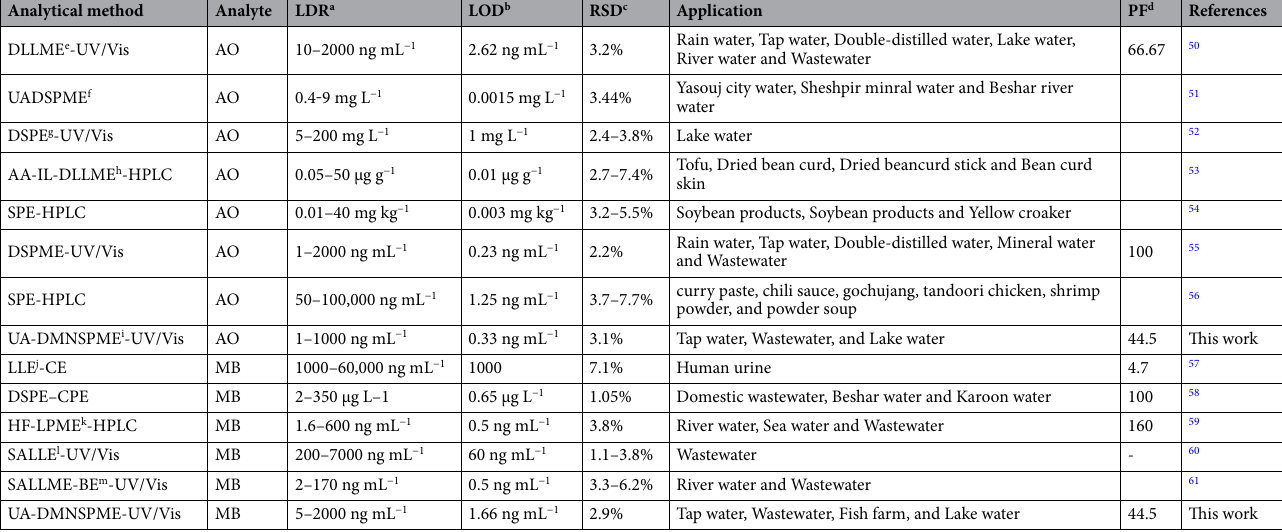
Table 7. Comparison of the present method with other extraction methods for the determination of AO and MB. a Linear dynamic range, b Limit of detection, c Relative standard deviation, d Preconcentration factor, e Dispersive liquid–liquid microextraction, f Ultrasound-assisted dispersive solid-phase microextraction, g Dispersive solid-phase extraction, h Air-assisted ionic liquid-based dispersive liquid–liquid microextraction, i Ultrasound-assisted dispersive-magnetic nanocomposites-solid-phase microextraction, j Liquid-liquid extraction, k Hollow fiber liquid-phase microextraction, l Salting-out assisted liquid–liquid extraction, m Shaker- assisted liquid–liquid microextraction combined with